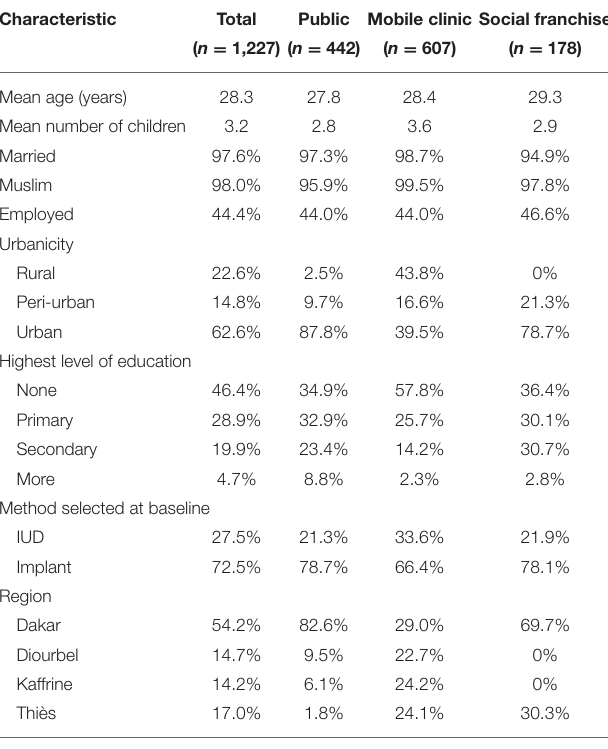
TABLE 1 | Baseline client characteristics, by recruitment service delivery